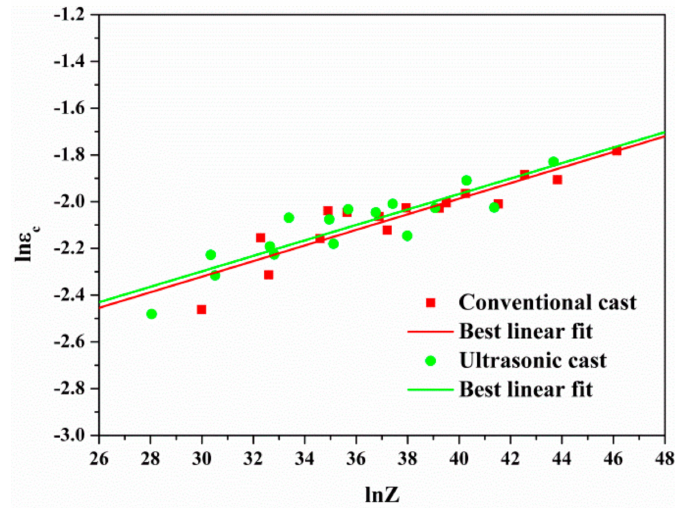
Figure 8. Relationship between ln ε c and ln Z